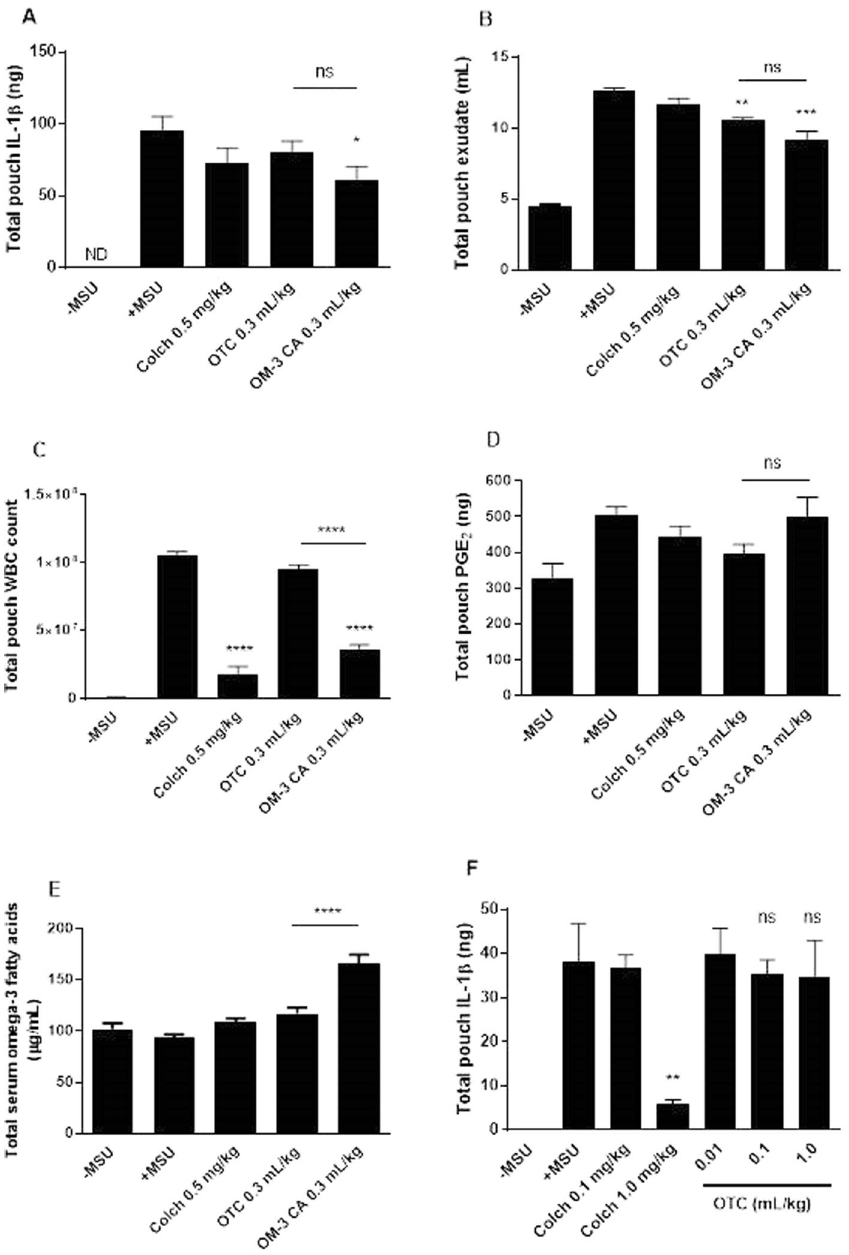
Figure 5. Comparison of OM-3 CA with OTC OM-3-triglycerides, both at amounts of 0.3 mL/kg/day, in the rat MSU air pouch model. ( A ) Mean IL-1 β production assayed from the exudate recovered from the air pouches for each treated group (n = 10 per group). ( B ) Mean exudate volume recovered from the air pouches for each treated group. ( C ) Mean number of WBCs recovered from the air pouches for each treated group. ( D ) Pouch exudate PGE 2 content presented as mean ± standard error of the mean. ns, not significant. * P < 0.05 versus + MSU using Kruskal–Wallis test with Dunn’s multiple comparison test ( A and D ), ** P < 0.01, *** P < 0.001, **** P < 0.0001 versus + MSU by one-way ANOVA with Bonferroni’s multiple comparison test. ( E ) Total serum omega-3 of comparator groups. **** P < 0.0001 using one-way ANOVA with Bonferroni’s multiple comparison tests. ( F ) IL-1 β endpoint on titrations of OTC OM-3-triglycerides up to 1.0 mL/kg. ns, not significant versus + MSU. ** P < 0.01 versus + MSU using Kruskal–Wallis tests with Dunn’s multiple comparison tests. ANOVA: analysis of variance; Colch: colchicine; IL-1 β : interleukin-1 β ; MSU: monosodium urate; ND: not detected; OM-3: omega-3; OM-3 CA: omega-3-carboxylic acids. OTC: over-the-counter OM-3 triglycerides; PGE 2 : prostaglandin E 2